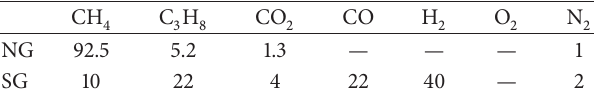
Table 1: Composition (vol, %) of fuel stream.